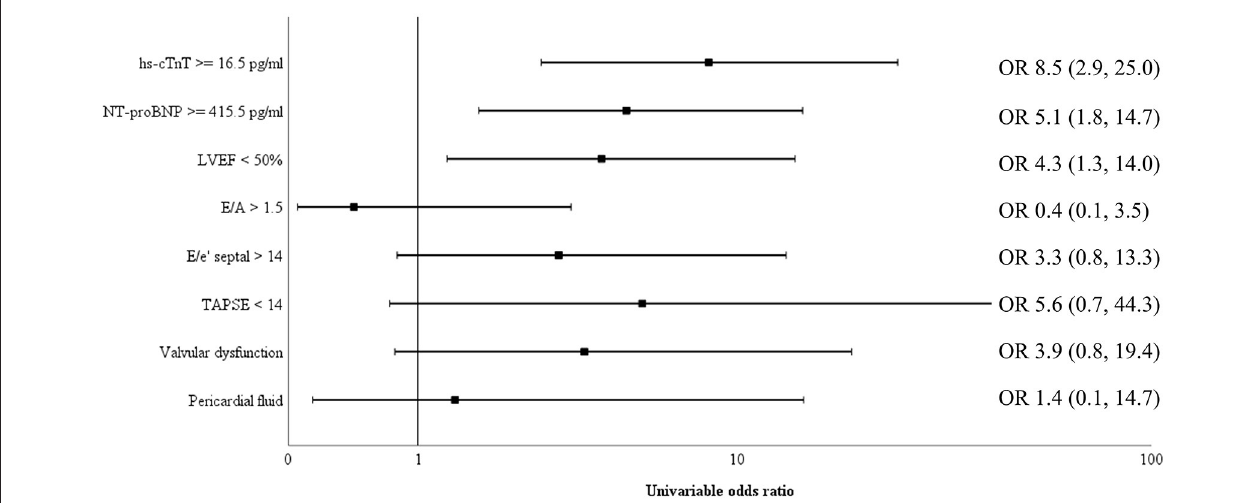
FIGURE 4 | Univariable odds ratio for 30-day all-cause mortality. Univariable odds ratio for 30-day all-cause mortality for cardiac biomarkers hs-cTnT and NT-proBNP as well as several echocardiographic measurements (reduced left ventricular ejection fraction (LVEF), increased E/e’, increased E/A, decreased tricuspid annular plane systolic excursion (TAPSE), valvular dysfunction and pericardial fluid). Both elevated cardiac biomarkers above their respective cut-off value and a reduced LVEF had a significant higher odds ratios for 30-day all-cause mortality. NT-proBNP, N-terminal pro-brain natriuretic peptide; hs-cTnT, high sensitive troponin T; TAPSE, tricuspid annular plane systolic excursion; LVEF, left ventricular ejection fraction; OR, odds ratio.